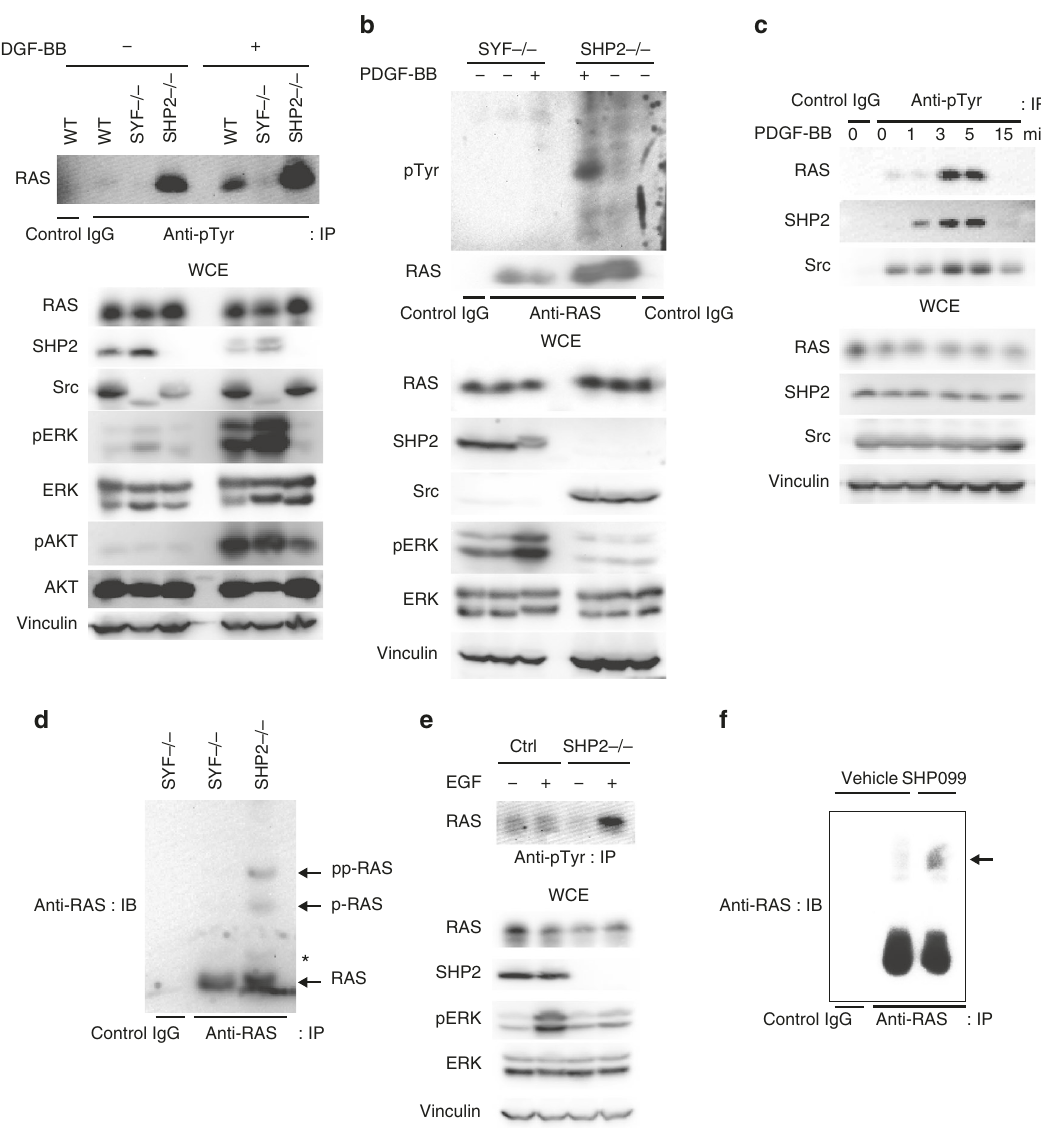
Fig. 4 Endogenous RAS phosphorylation is regulated temporally by Src and SHP2. a WT, Src/Yes/Fyn (SYF) − / − and CRISPR/Cas9-mediated SHP2 − / − MEFs were serum starved and treated with 20 ng/ml of PDGF-BB. Equal amounts of lysates were immunoprecipitated with isotype-matched antibody or anti-pTyr antibody and immunoblotted with the indicated antibodies. b SYF − / − and SHP2 − / − MEFs were serum starved and treated with 20 ng/ml of PDGF-BB. Equal amounts of lysates were immunoprecipitated with isotype matched antibody or anti-RAS antibody and immunoblotted with the indicated antibodies. c MEFs were serum starved and treated with 20 ng/ml of PDGF-BB or were left untreated for the indicated periods of time. Equal amounts of lysates were immunoprecipitated with isotype-matched antibody or anti-pTyr antibody and immunoblotted with the indicated antibodies. d SYF − / − and SHP2 − / − MEF lysates were immunoprecipitated with isotype-matched antibody or anti-RAS antibody and analyzed by 50 μ M Mn 2 + -PhosTag SDS-PAGE. Asterisk indicates non-speci fi c band. e CRISPR/Cas9-mediated non-target (Ctrl) or SHP2 − / − CFPAC1 cells were serum starved and treated with ( + ) or without ( − ) 10 ng/ml of EGF. Equal amounts of lysates were immunoprecipitated and immunoblotted with the indicated antibodies. f OCIP.343 xenograft tumor lysates from the indicated treatment groups were immunoprecipitated with isotype-matched antibody or anti-RAS antibody and analyzed by Mn 2 + -PhosTag SDS-PAGE. Arrow indicates a slower migrating band. The immunoblot data are representative of at least three independent